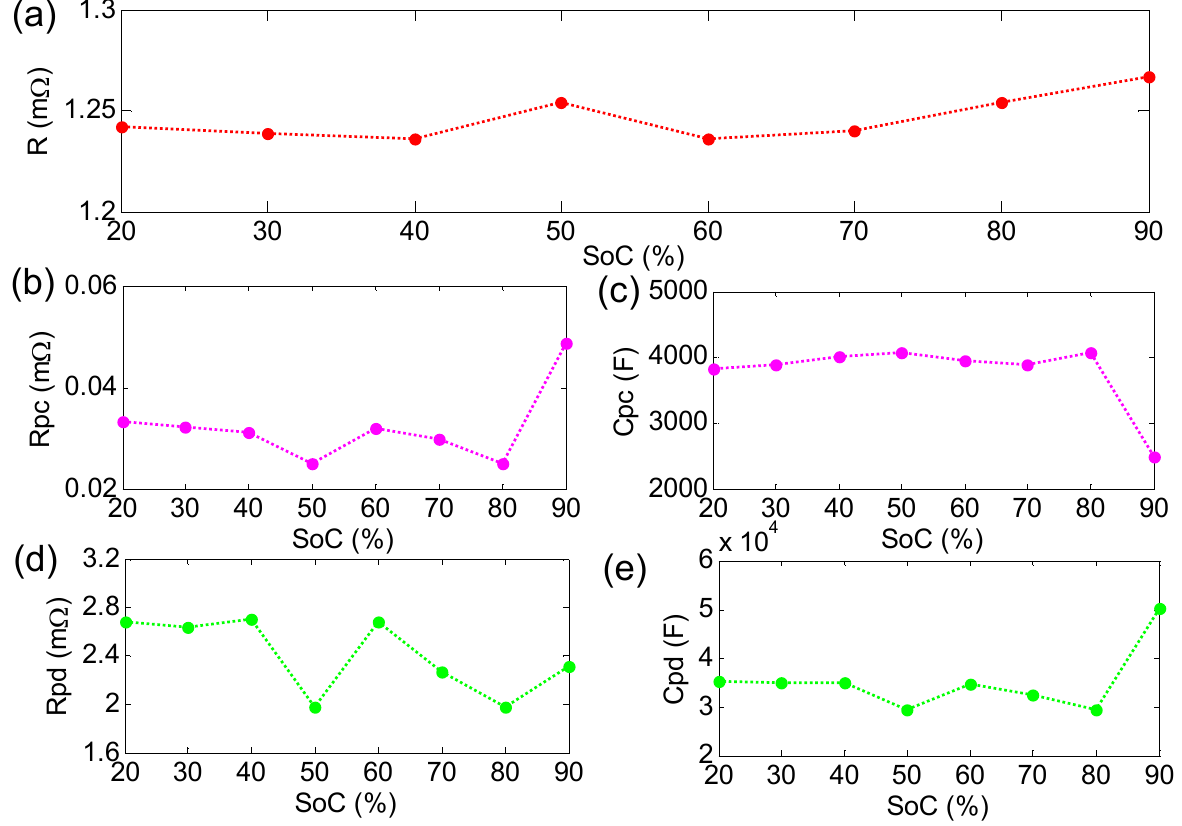
Figure 6. Parameters identification results. ( a ) Identified R ; ( b ) Identified R pc ; ( c ) Identified C pc ; ( d ) Identified R pd ; ( e ) Identified C pd